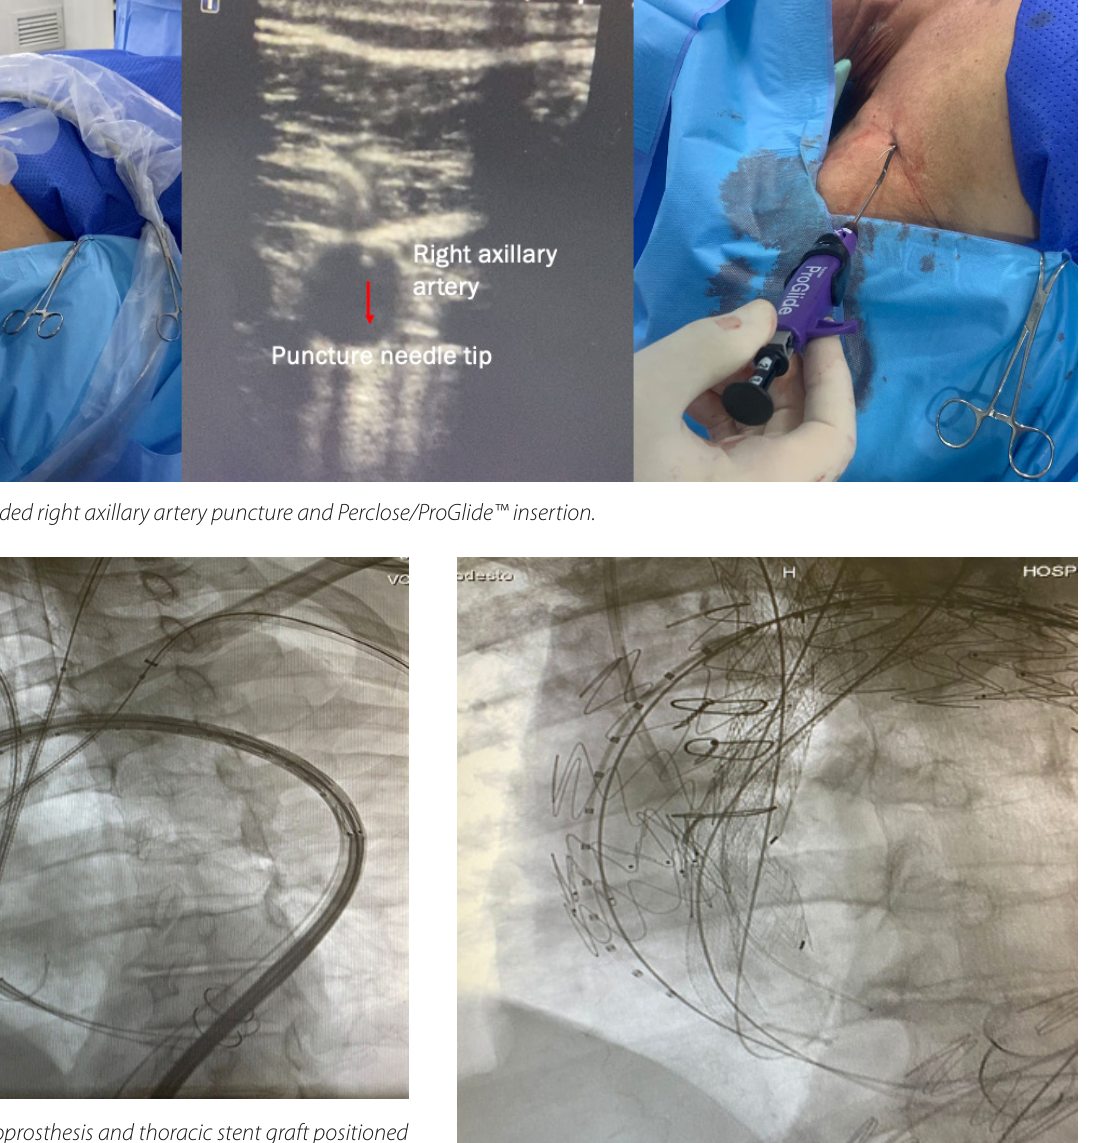
Fig. 3 - VIABAHN® endoprosthesis and thoracic stent graft positioned into the brachiocephalic trunk, left carotid artery, left subclavian artery, and aortic arch.